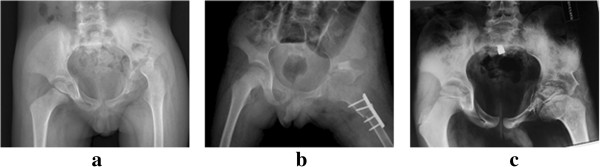
Serial radiographs of a 6-year-old boy who presented with tuberculosis of left hip dislocation. He was treated by left open reduction, Pemberton pelvis osteotomy, and corrective osteotomy in the left proximal femur. (a) Pre-operative. (b) Immediate post-operative. (c) 2 years post-operative.